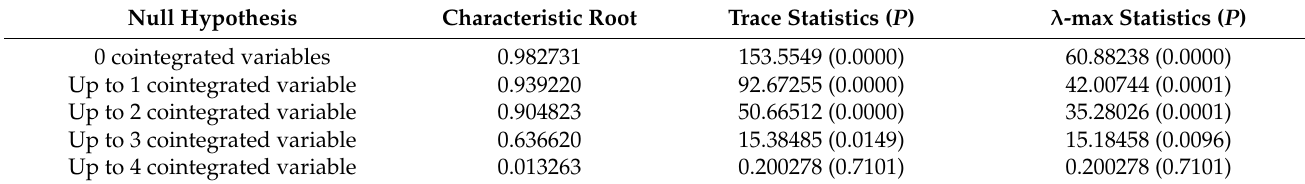
Table 6. Cointegration test results.